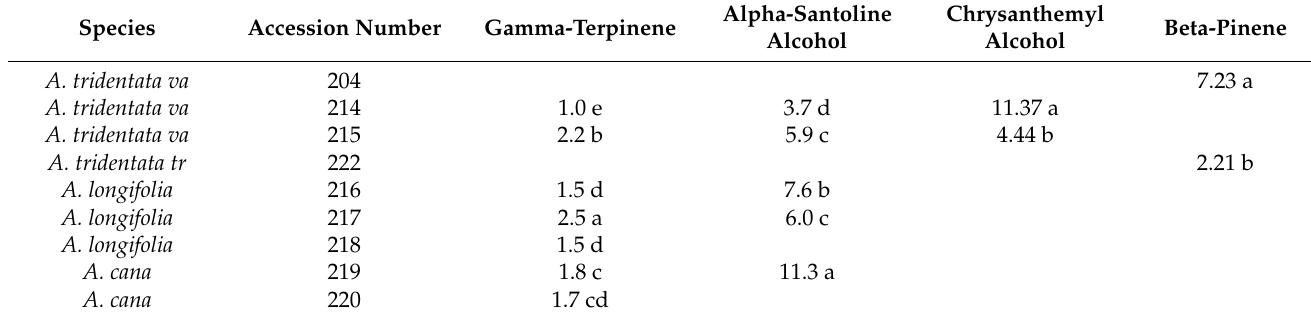
Table 6. Mean gamma-terpinene, alpha-santoline alcohol, chrysanthemyl alcohol and beta-pinene (all in %) from four species and their subspecies. Blank cells indicate the constituents were not obtained from these accessions. A. tridentata va = A. tridentata Nutt. var. vaseyana ; A. tridentata tr = A. tridentata Nutt. var. tridentata